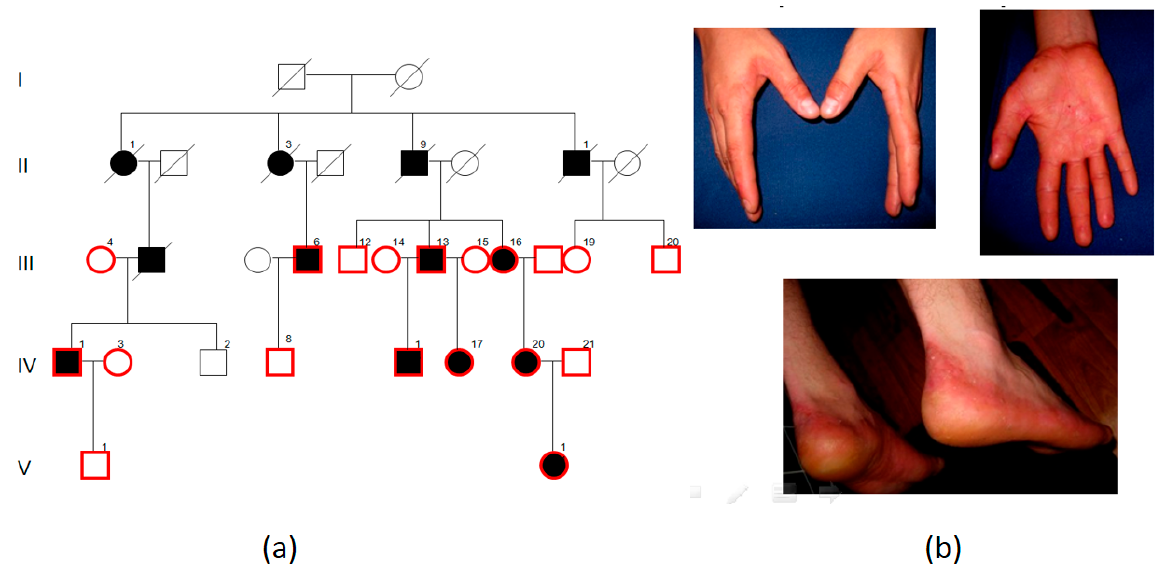
Figure 1. PPK1 pedigree: black—affected family members, white—healthy family members, I–V—generations, 1–21—number of the person in the generation, red contour—symbols corresponding to the examined and genotyped family members ( a ); symptoms of palmoplantar keratoderma in patients: soft yellow diffuse keratoderma on palms and soles, keratolysis and erythematous plaques with a clear demarcation line on the borders of the affected zones of palms and soles ( b ).